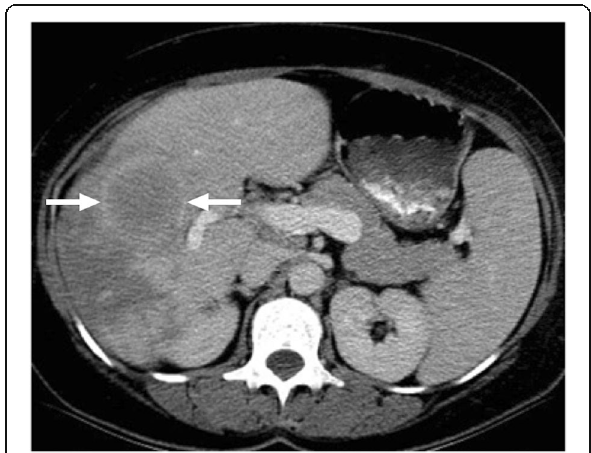
Fig. 15 A 40-year-old female presenting with mild fever and liver mass on US examination. Axial plane postcontrast CT image demonstrates ill-defined, hypoattenuating mass (arrows) in the right lobe with accompanying wide parenchymal area of disturbed perfusion. Percutaneous biopsy revealed basophilic aggregates and sulfur granules consistent with actinomycetes infection. Post- antibiotic treatment demonstrated almost complete regression of the imaging findings (not shown)